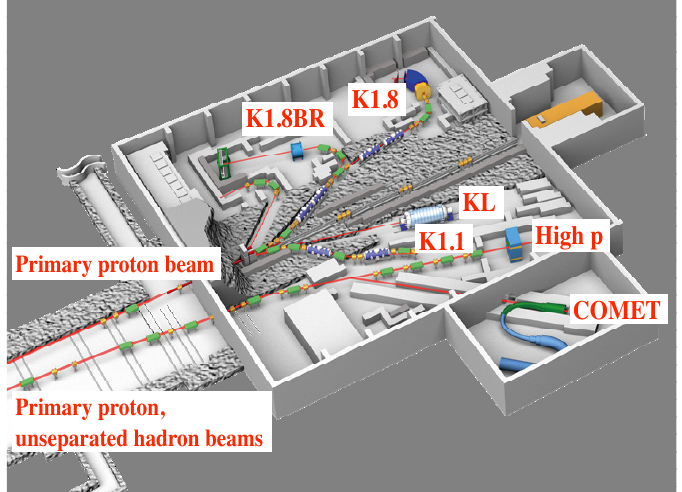
Figure 8. The Japan Proton Accelerator Research Complex (J-PARC) hadron